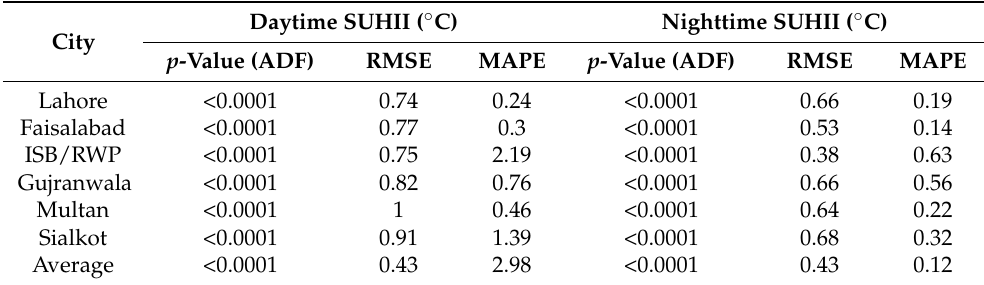
Table 5. RMSE, MAPE and p(ADF) for the fitted ARIMA